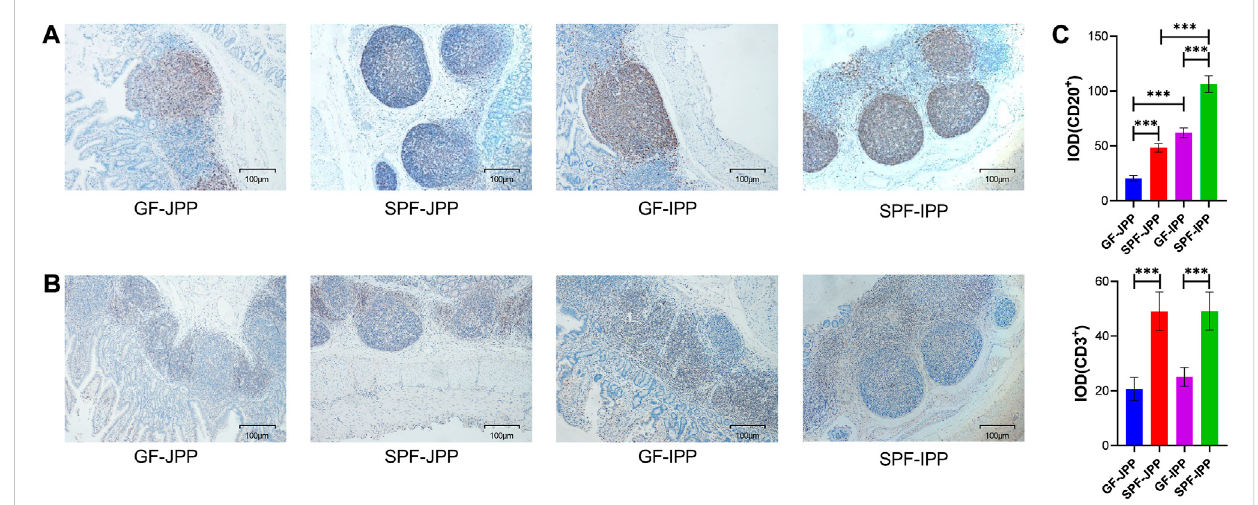
FIGURE 3 The distribution of B and T cells in intestinal PPs. The distribution of B and T cells detected by IHC staining for pig-speci fi c CD20 (A) and CD3 (B) antibodies,respectively;brownindicatesB/Tcellspeci fi cstaining;scalebar:100 μ m. (C) QuantitativeanalysisoftheproportionofCD20 + andCD3 + cells. Means ± SDs are presented for each group. n = 3. *** p <